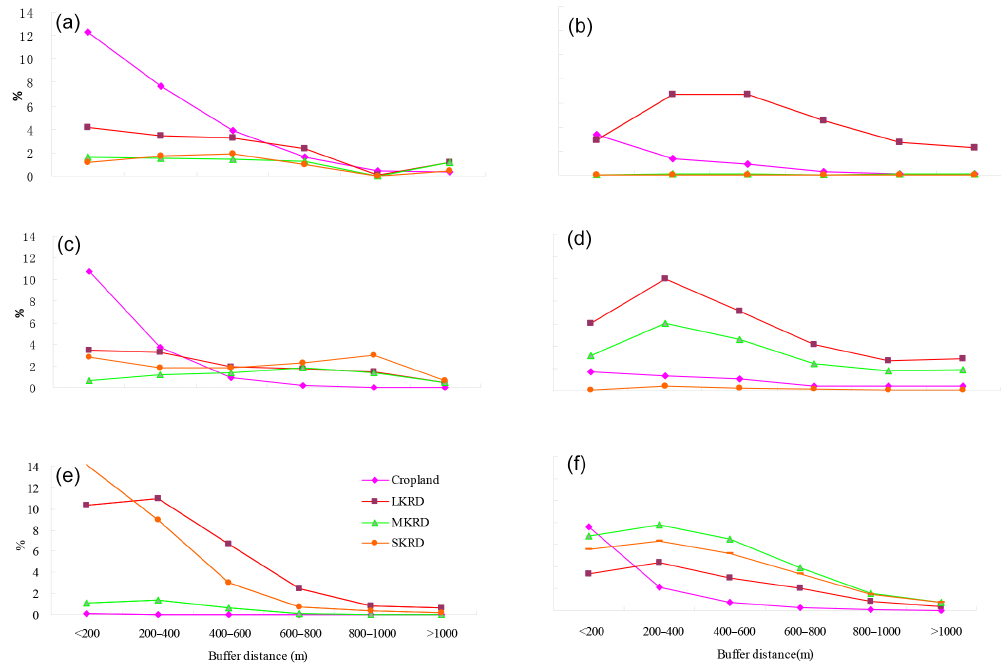
Figure 4. The proportions of cropland and KRD of different buffers accounting for the total area of the study area. (a) Peak-cluster depression surrounded by shallow hills. (b) Shallow depression. (c) Open peak-cluster depression. (d) Continuous deep depression. (e) Peak-cluster canyon. (f) Peak-cluster depression–valley